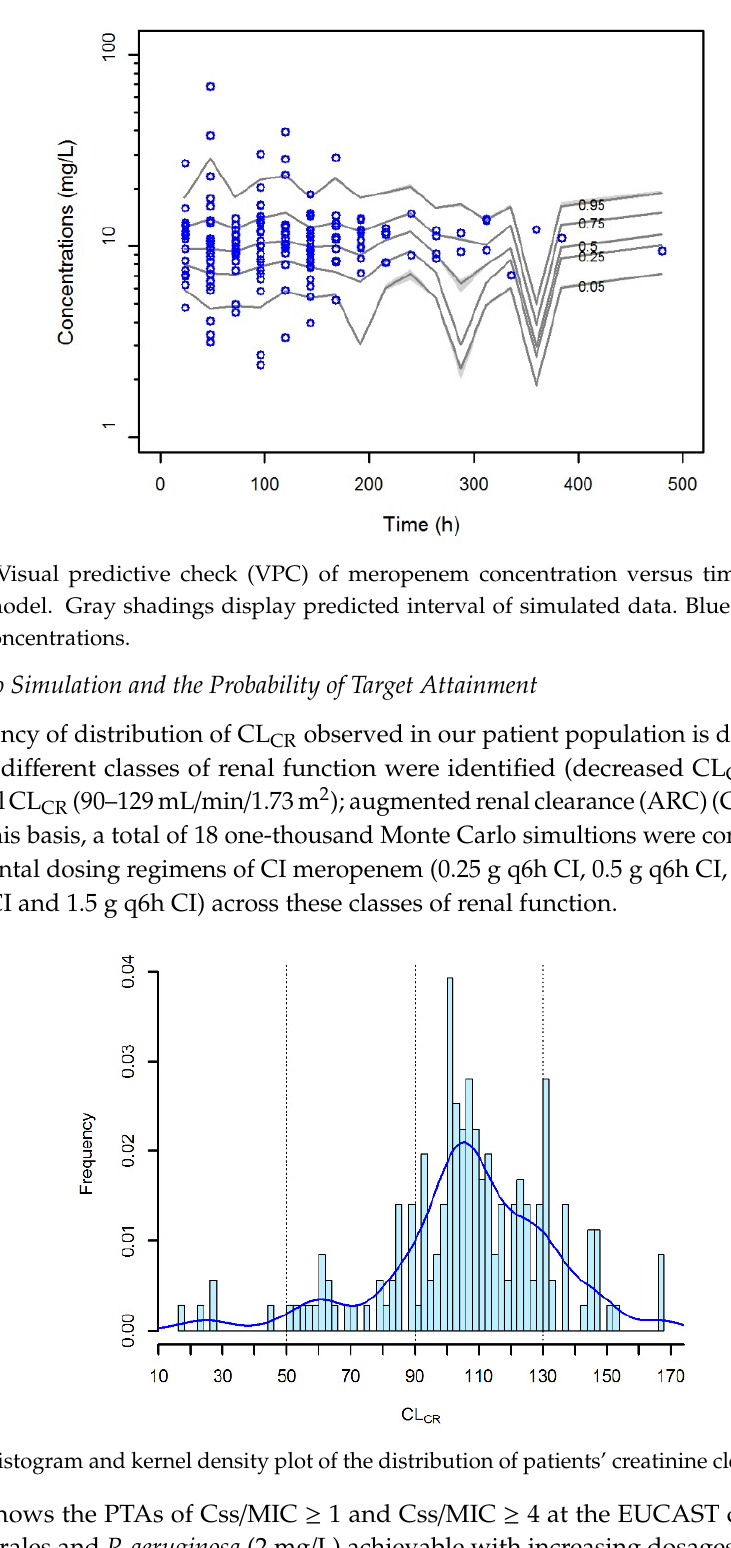
Figure 4. Probability of target attainments (PTAs) of Css/MIC ≥ 4 (solid lines) and Css/MIC ≥ 1 (dashed lines) at the EUCAST clinical breakpoint of 2 mg/L against Enterobacterales and P. aeruginosa with incremental dosages of continuous infusion meropenem in relation to different classes of CL CR . Horizontal broken line identifies the threshold for optimal PTA ( ≥ 90%). The CFRs achievable at Css/MIC of ≥ 4 and ≥ 1 against the EUCAST MIC distributions of E. coli , K. pneumoniae , E. cloacae and P. aeruginosa with incremental dosages of CI meropenem in different classes of renal function are summarized in Table 3. Optimal CFRs against E. coli , K. pneumoniae and